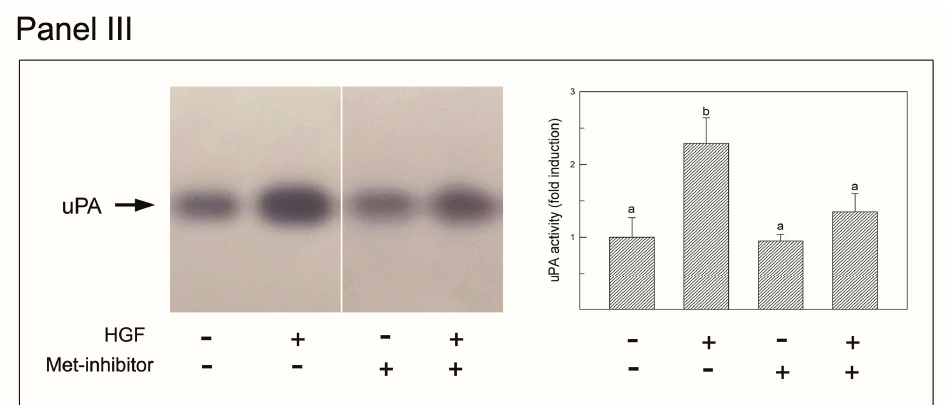
Figure 6. HGF mediated a uPA secretion increase in purified myoid cells and in cultured seminiferous tubules. ( Panel I ) Dose-response curve of uPA secreted by purified myoid cells cultured for 24 h in the presence of increasing doses of HGF (25–300 U/mL; 7.5–90 ng/mL). Aliquots of conditioned medium were analyzed by SDS-PAGE followed by